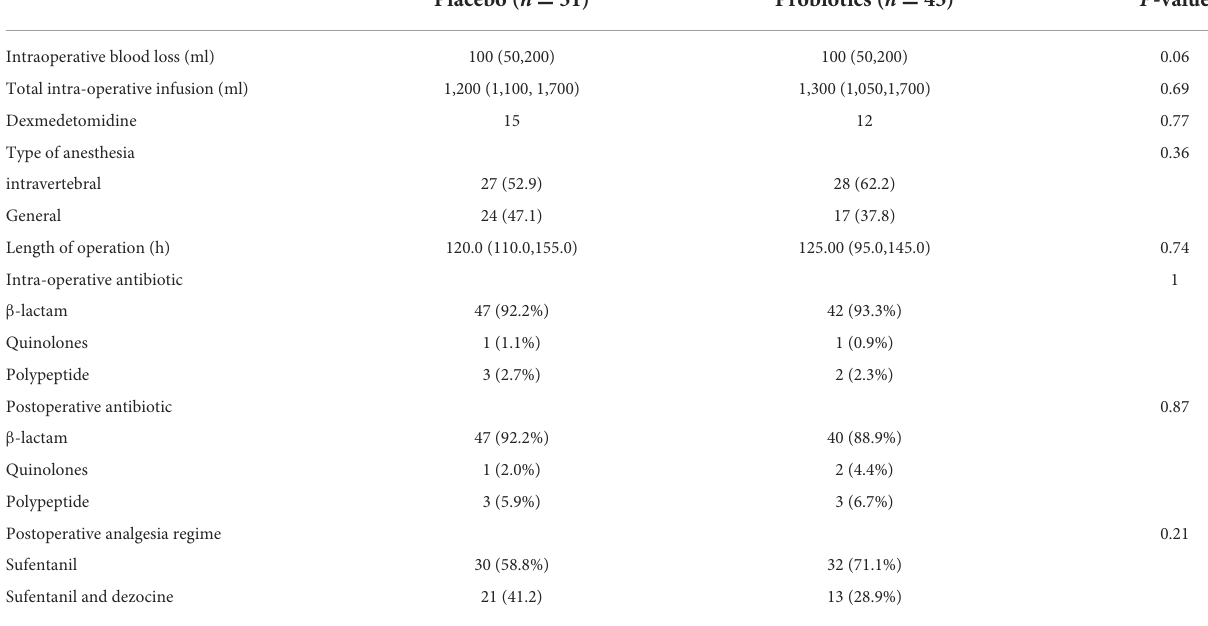
TABLE 3 Parameters during anesthesia and surgery.